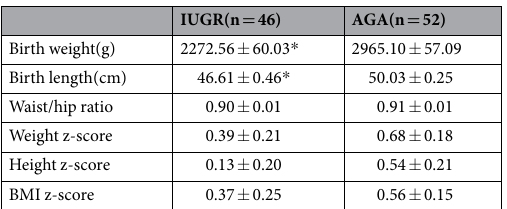
Table 2. Comparison of anthropometric parameters between children born IUGR and AGA at birth and at the observation time expressed as mean ± S.E. Statistical comparisons were performed with multiple factors ANOVA. * denotes statistically significant difference from the respective AGA